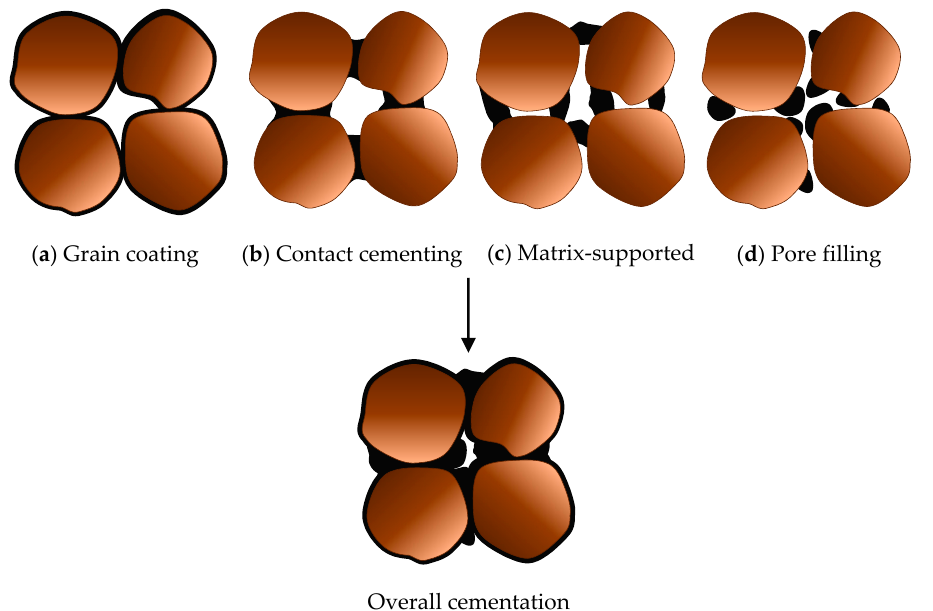
Figure 1. Cementation mechanism of microbial induced carbonate precipitation ( a ) grain coating; ( b ) contact cementing; ( c ) matrix-supported; ( d ) pore-filling.